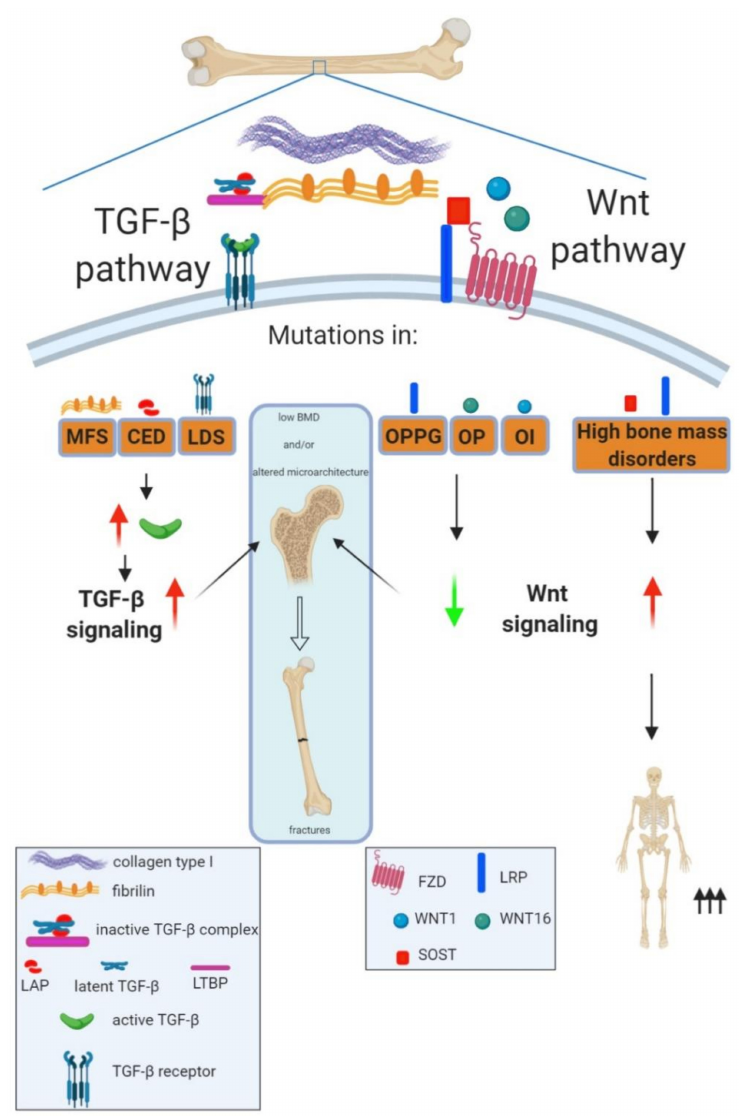
Figure 1. Roles of transforming growth factor beta (TGF- β ) and Wnt signaling in bone strength